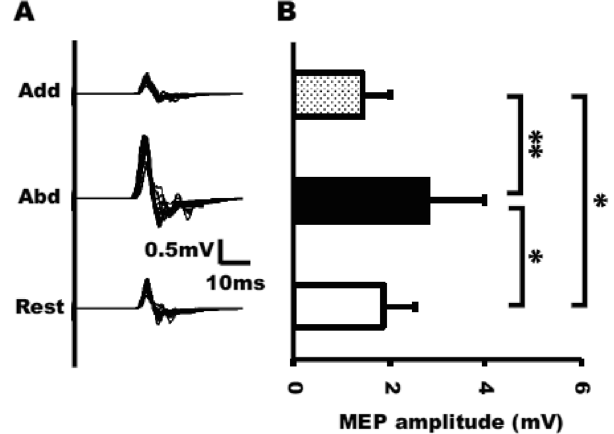
Figure 3. Superimposed raw MEP amplitude for a representative subject recorded from the FDI muscle during MI + AO of index finger abduction (abd), adduction (add), and rest phases ( A ). Average ± SD of the FDI MEP amplitude during MI of three phases ( B ). ( * p < 0.05; ** p < 0.01).